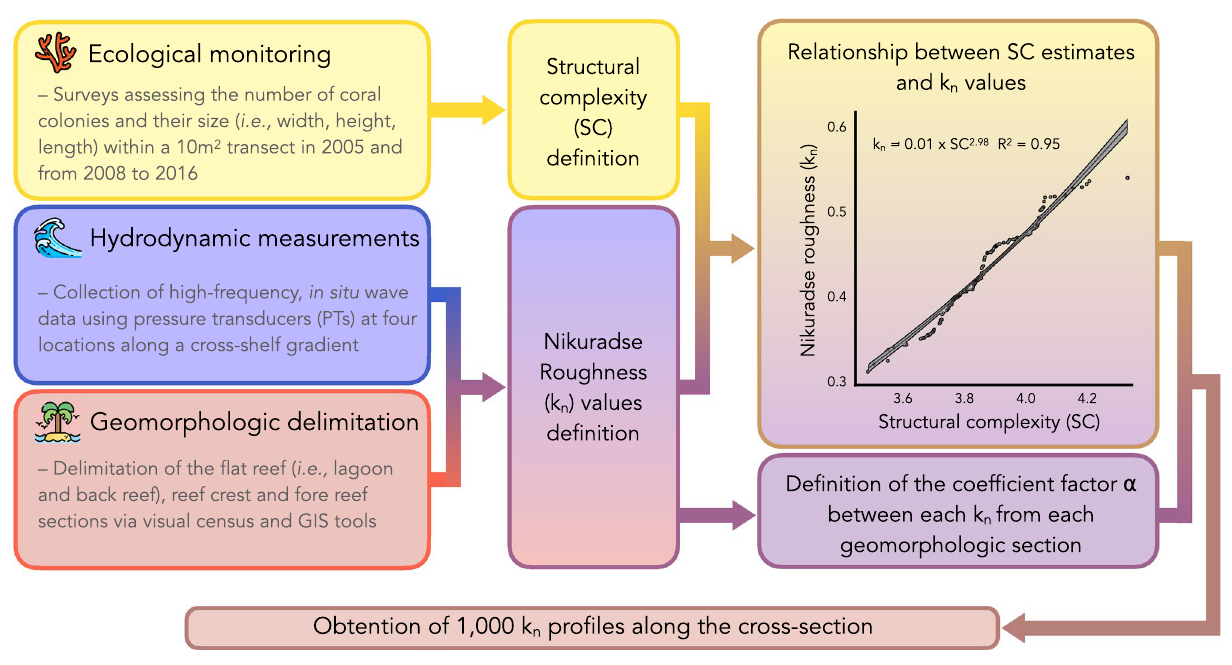
Figure 3. Flow chart illustrating how the k n profiles have been obtained along the cross-section at Ha’apiti. The relationship between the Structural complexity (SC) and the Nikuradse roughness (k n ) measurements can be described as k n = 0.01 × SC 2.98